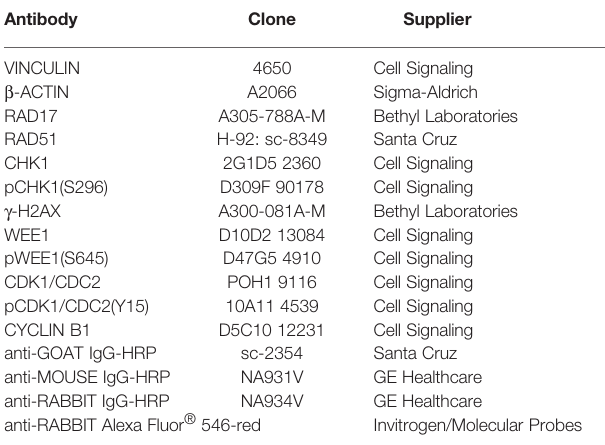
TABLE 1 | List of the antibodies used.